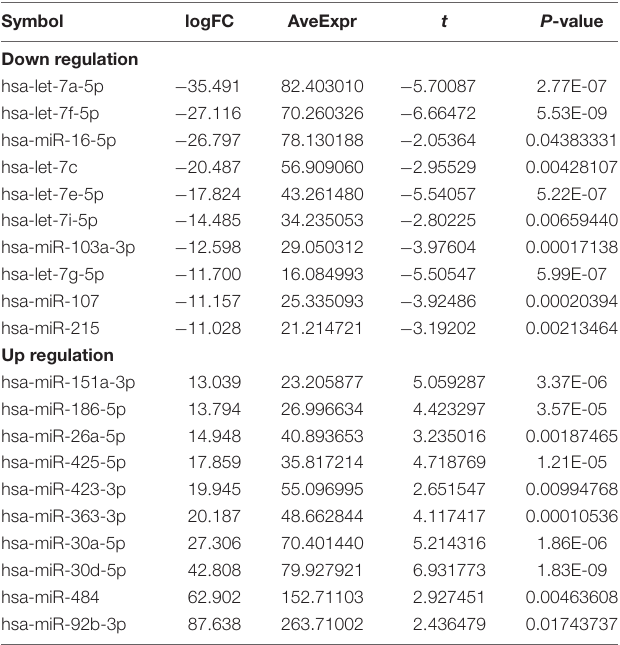
TABLE 3 | Top 10 (up- and down-regulated) of differentially expressed miRNAs in Alzheimer’s disease expression profile.